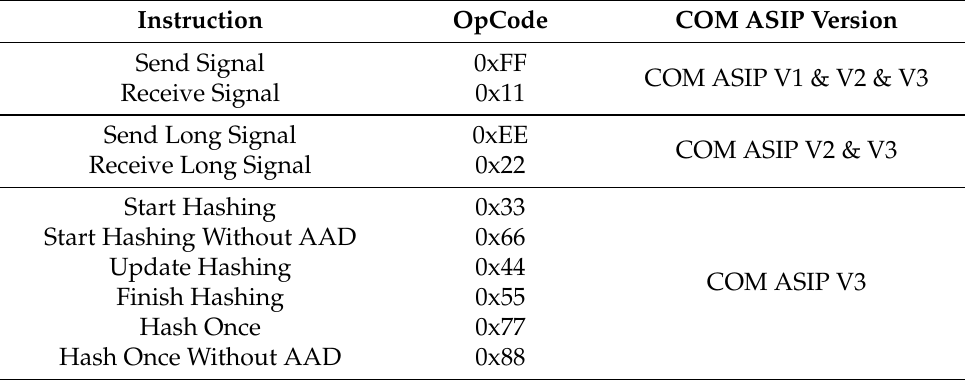
Table 3. The instructions supported by different versions of COM